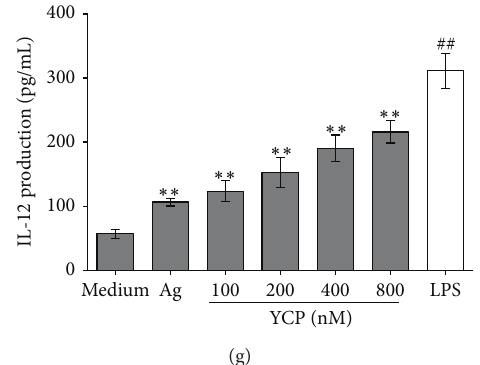
Figure 2: The effect of YCP on DCs. (a) The expression of CD11c on DCs after 7-day generation with GM-CSF and IL-4. (b) The percentage of mature DCs (CD11c + /MHC II + ) stimulated by Ag and YCP at the indicated concentrations. ((c) and (d)) CD80 on dendritic cells at different times (6h, 12h, 24 h, and 48 h) after the stimulations with medium/Ag/YCP+Ag/LPS+Ag. ((e) and (f)) CD86 on dendritic cells at different times (6h, 12h, 24h, and 48 h) after the stimulations with medium/Ag/YCP+Ag/LPS+Ag. (g) Effect of YCP on DC IL-12 production. DCs were treated with Ag or YCP+Ag or LPS at the indicated concentrations, and IL-12 production was measured by ELISA assay at 48 h ( 𝑛 = 6 , ∗ 𝑃 ≤ 0.05 , ∗∗ 𝑃 ≤ 0.01 versus medium by Kruskal-Wallis test followed by Dunn’s post hoc test. ## 𝑃 ≤ 0.01 versus medium by Mann-Whitney 𝑈